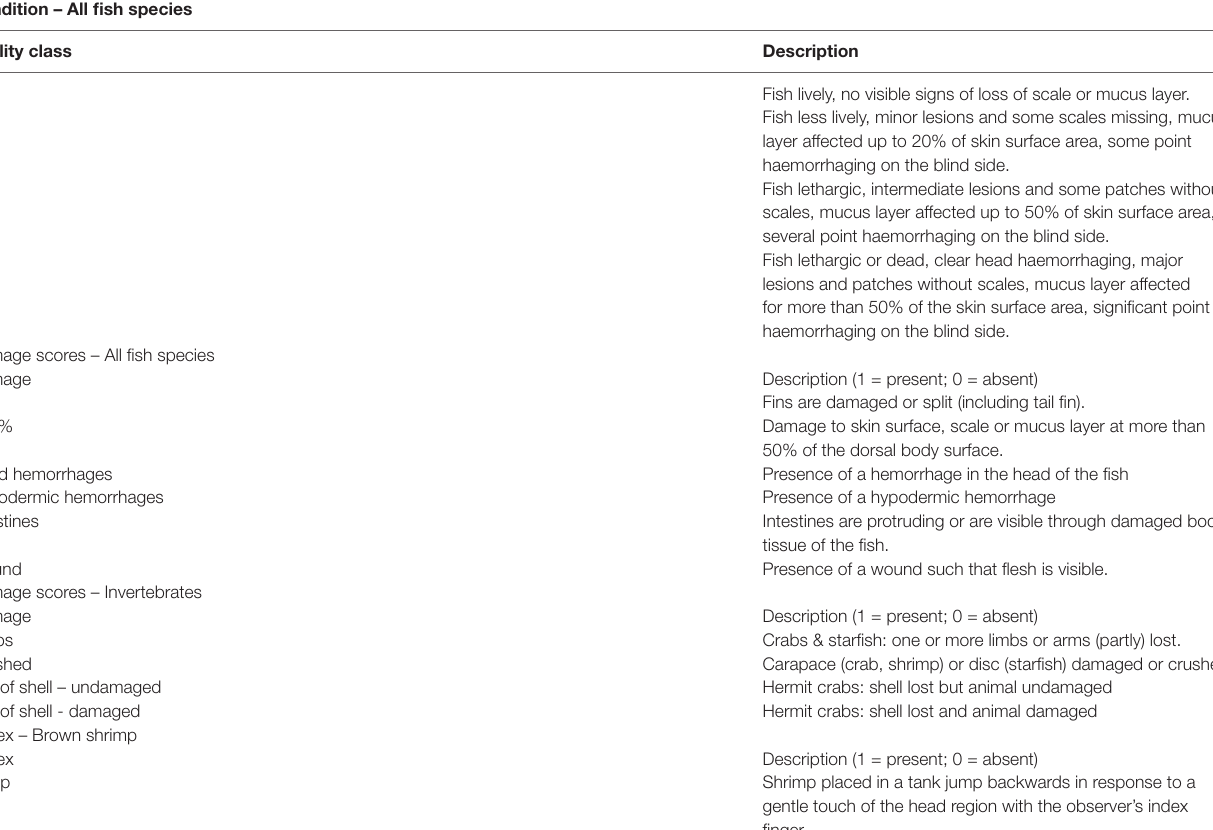
TABLE 2 | Description of condition